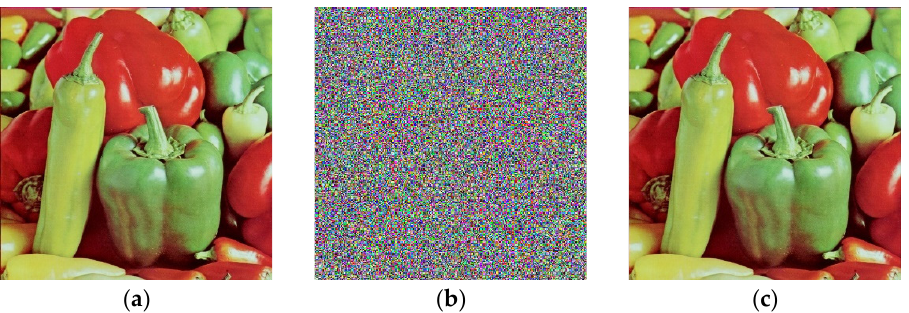
Figure 7. Peppers encryption process. ( a ) Original image Peppers; ( b ) encrypted image Peppers; ( c ) decrypted image Peppers.